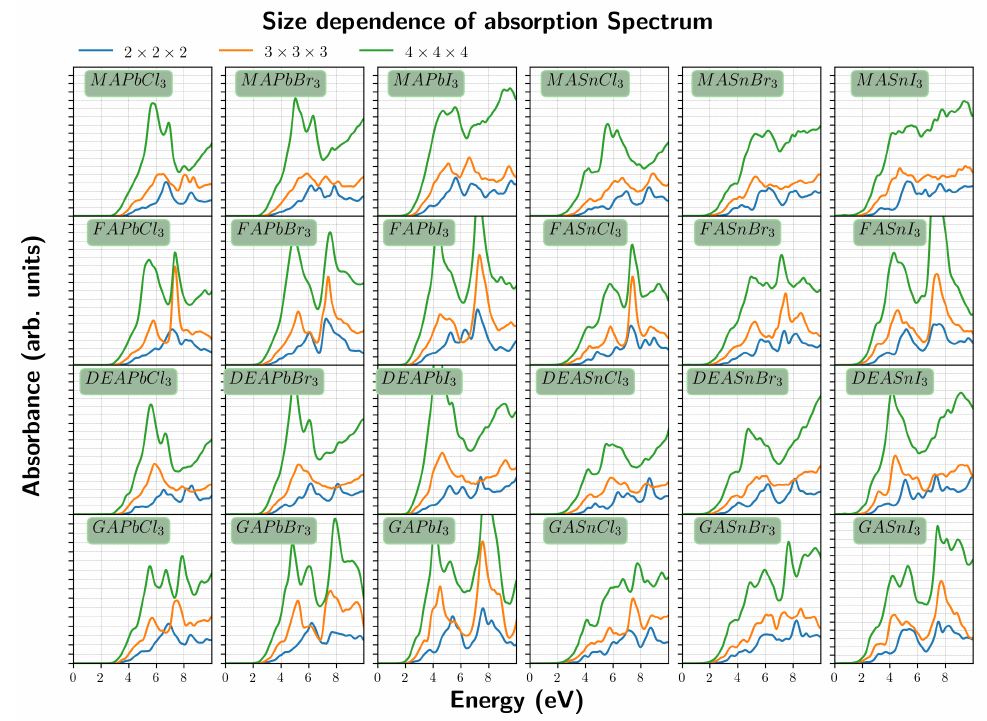
Figure 5. Dependence of the absorption spectra on the size of the nanoparticle (i.e., 2 × 2 × 2, 3 × 3 × 3 and 4 × 4 × 4